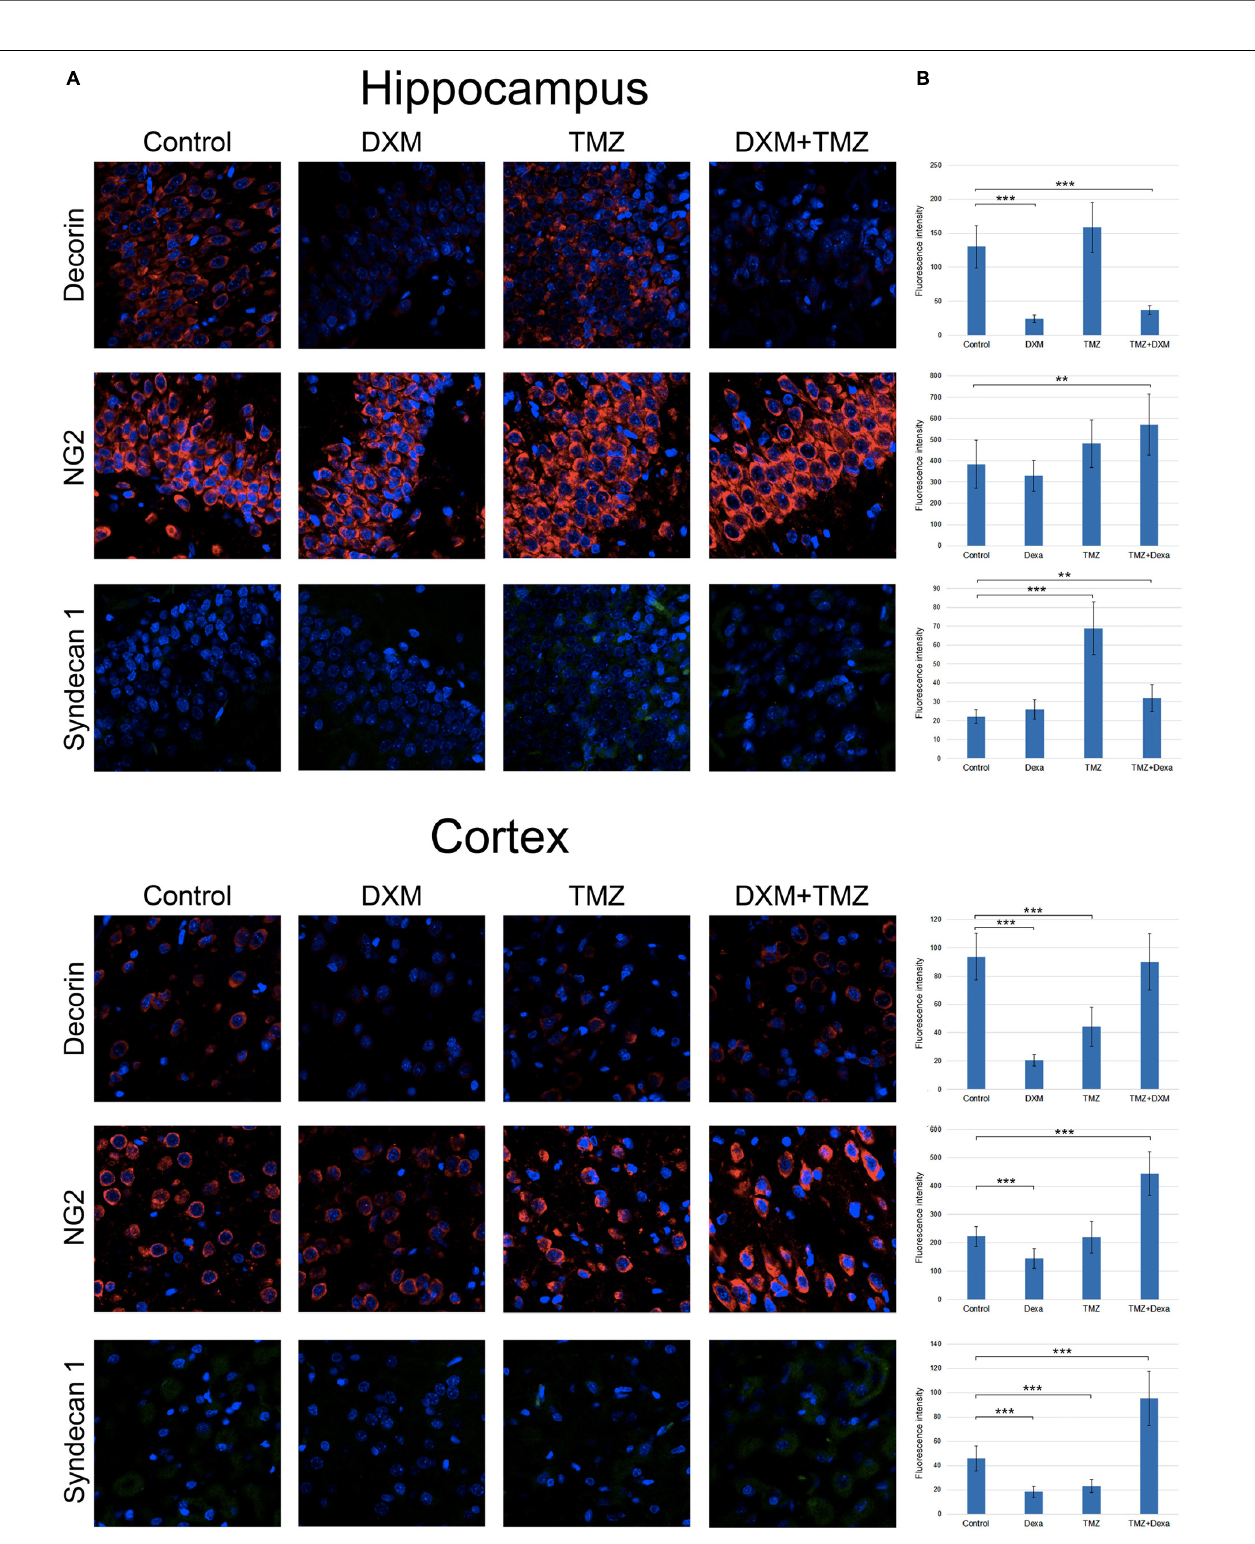
FIGURE 5 | Immunofluorescence analysis of PG core proteins content in rat brain before and after treatments with DXM and/or TMZ. (A) Immunostaining with anti-decorin, anti-CSPG4/NG2, or anti-syndecan-1 antibodies. Visualization with secondary antibodies Alexa Fluor 647 (red, for decorin and CSPG4/NG2) or Alexa Fluor 488 (green, for syndecan-1). Magnification ∗ 400. (B) . Quantitative analysis of the PG core proteins content in the control and treated rat brain tissues (CellProfiler 2.2.0 software). Student’s t -test, ∗ p < 0.05, ∗∗ p < 0.01 and ∗∗∗ p < 0.001.